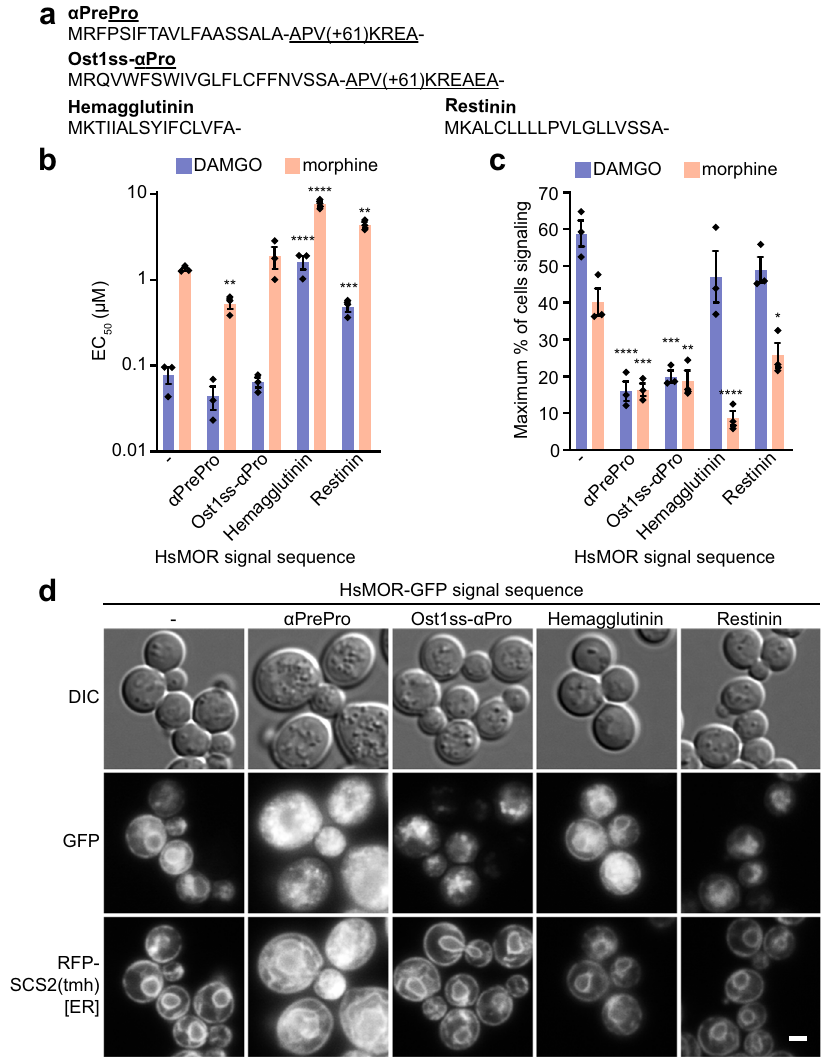
Fig. 3 Effect of signal sequences on HsMOR function. a N-terminal signal sequences tested on HsMOR. b Effect of signal sequences on HsMOR biosensor sensitivity to DAMGO and morphine. Unpaired one-way ANOVA of pEC 50 s: n = 3 biologically independent experiments, >7595 cells/strain/replicate; P < 0.0001 for each agonist; Dunnett ’ s multiple comparisons tests against WT shown. c Effect of signal sequences on HsMOR signaling population. Unpaired one-way ANOVA: n = 3 biologically independent experiments, >7595 cells/strain/replicate; P < 0.0001 (DAMGO) and P < 0.001 (morphine); Dunnett ’ s multiple comparisons tests against WT shown. d Imaging of HsMOR-GFP with the indicated signal sequences in a cholesterol-rich background with the ER marker RFP-SCS2(tmh). n = 3 biologically independent experiments. Data presented as mean + / − SEM. Scale bar is 2 μ m. *, P < 0.05; **, P < 0.01; ***, P < 0.001; ****, P < 0.0001. Source data are provided as a Source Data fi